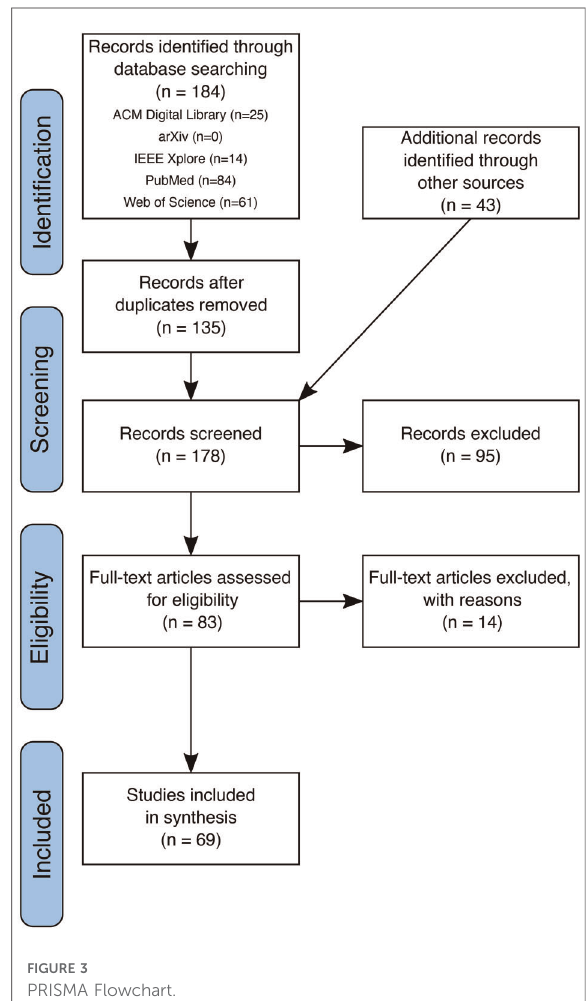
FIGURE 3 PRISMA